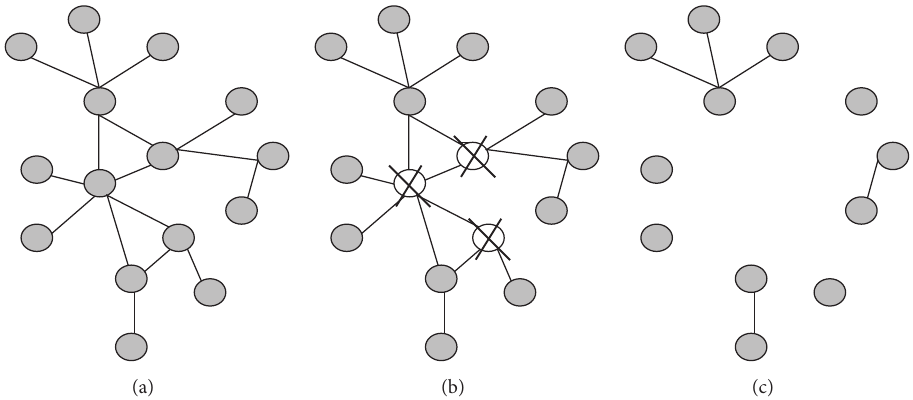
Figure 2: (a) A toy network. (b) Few nodes are removed from the network. (c) The remaining clusters in the